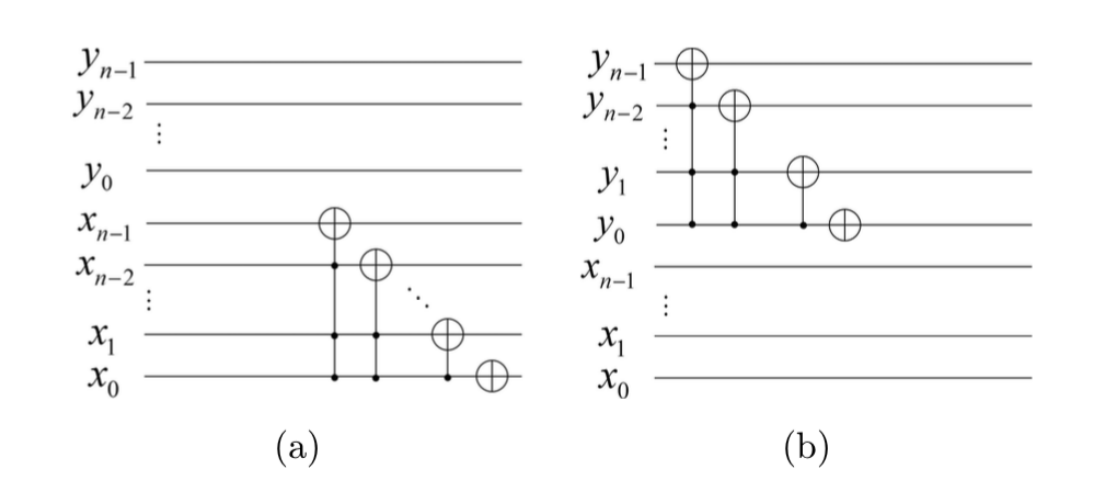
Figure 4. Quantum circuit for position shifting transformation. The function of the circuit is to add one to the n-qubit number. ( a ) The position shifting transformation of x . ( b ) The position shifting transformation of y